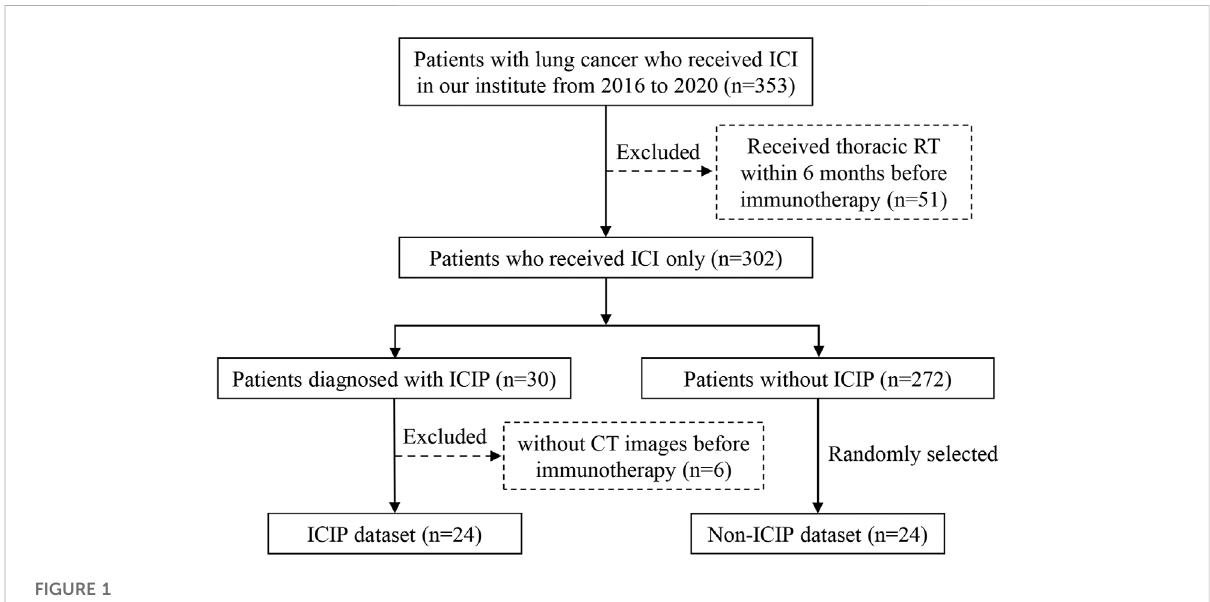
FIGURE 1 Flowchart for patient